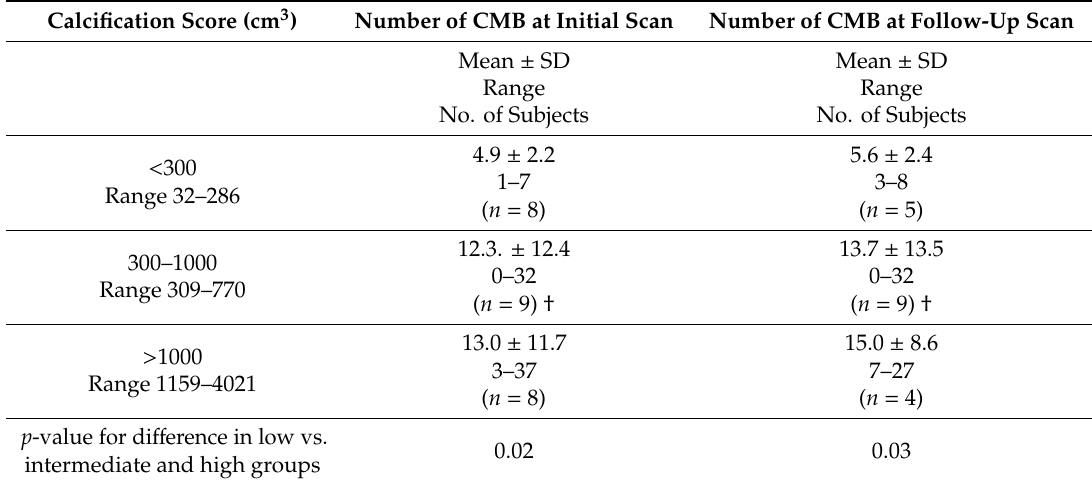
Table 2. Vascular calcification scores and cerebral microbleed (CMB) counts in 26 patients.